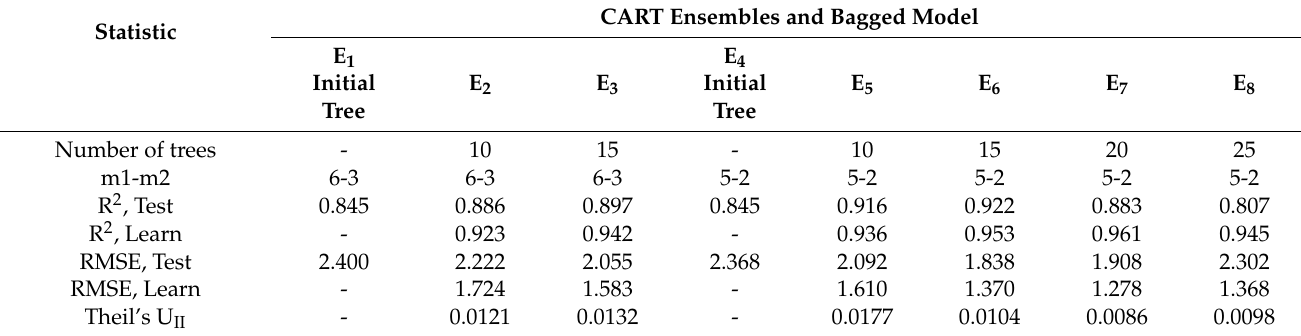
Table 5. Summary statistics of regression CART ensembles and bagged models for assessment of students’ achievements.